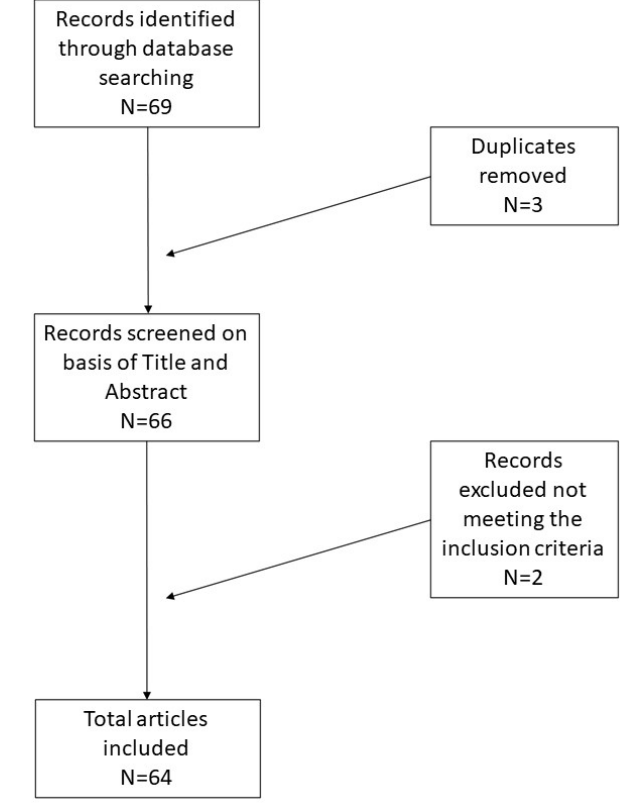
Figure 1. Selection of articles following PRISMA guidelines.